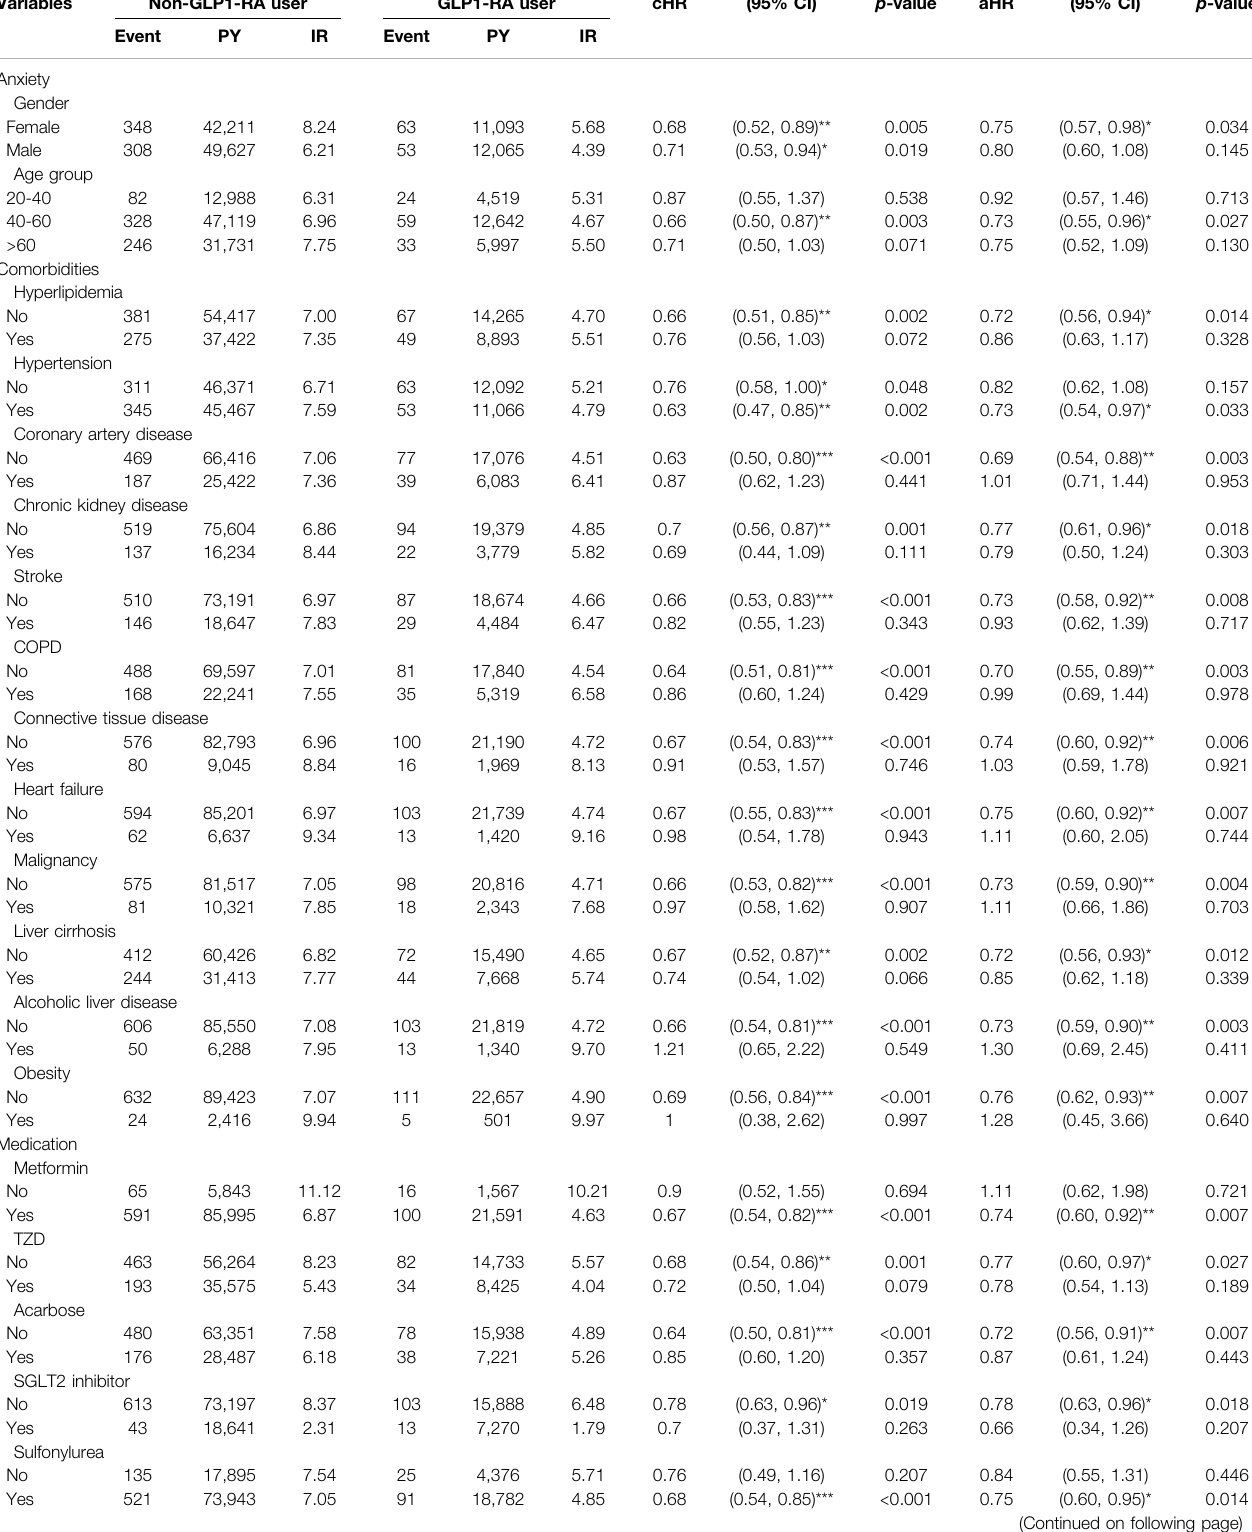
TABLE 3 | Factors associated with anxiety incidence in diabetes patients with/without GLP1-RA: subgroup analysis.